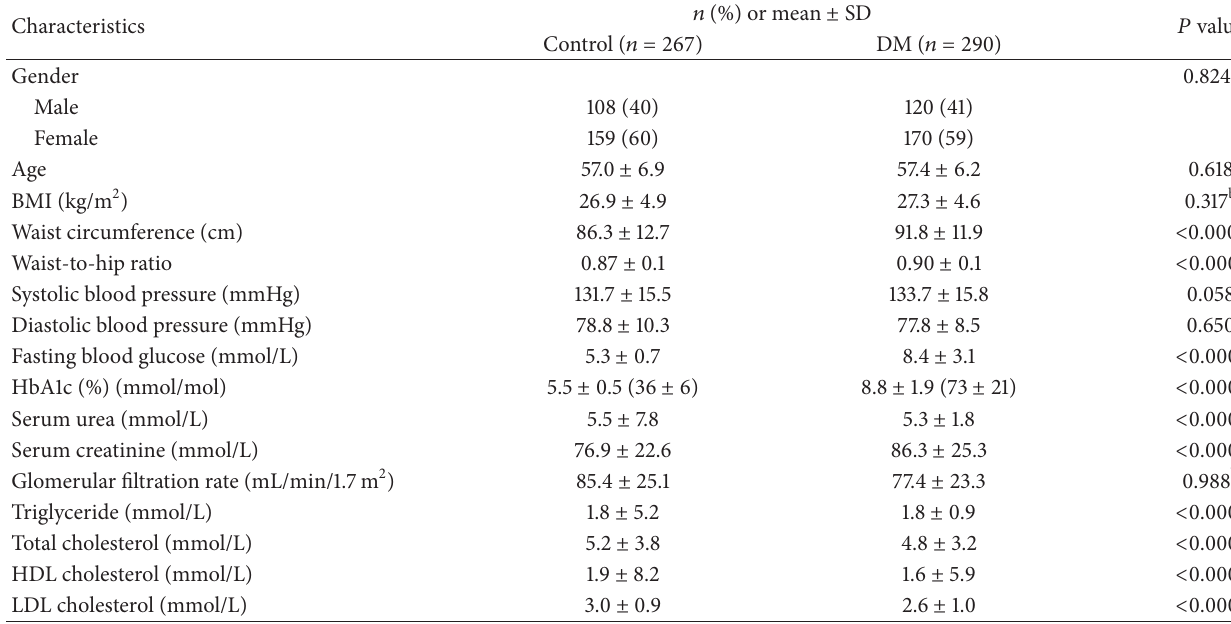
Table 1: Demographic and clinical data of participants.